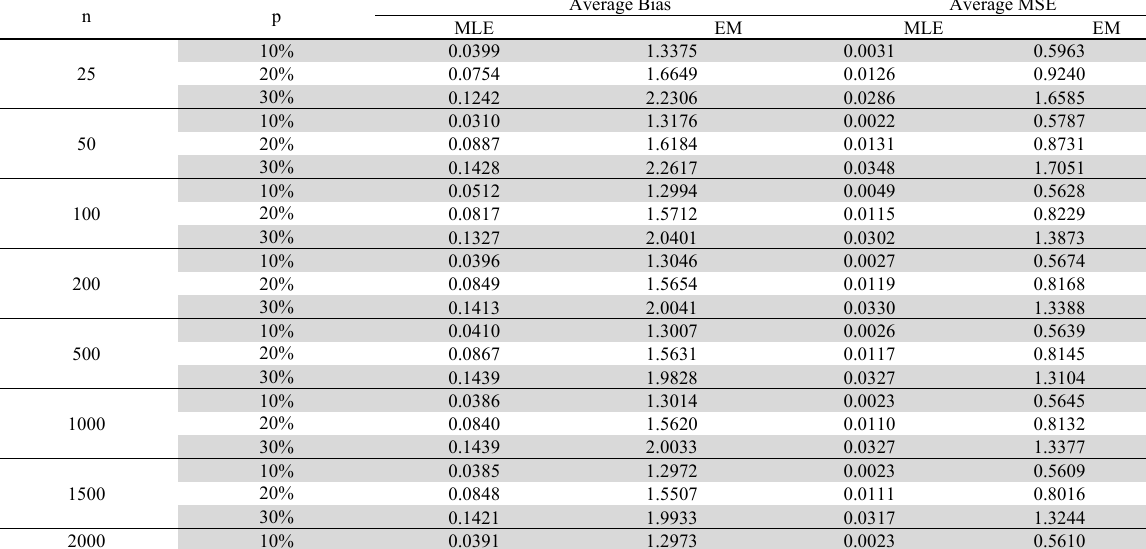
Estimate values of Bias and MSE by method MLE and